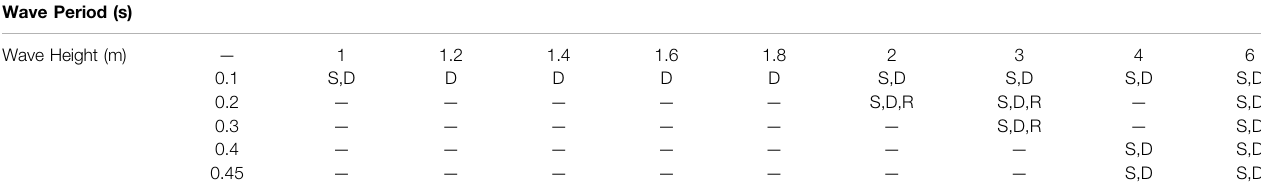
TABLE 1 | List of wave conditions tested on the 50% scaled Tutu mat network. Wave Period (s) Wave Height (m)